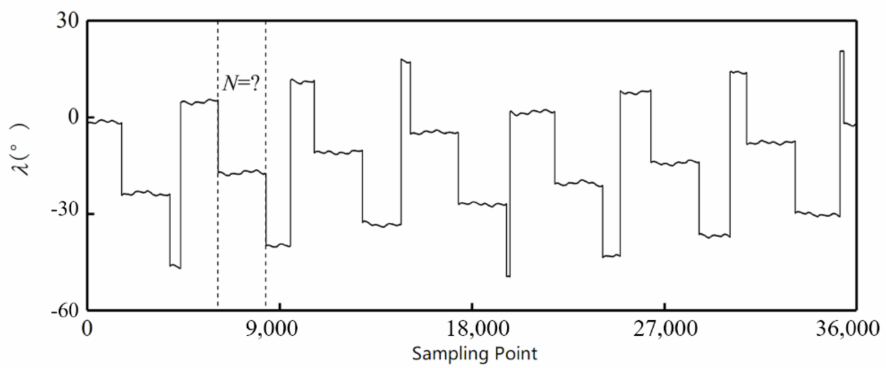
Figure 5. Calculated characteristic